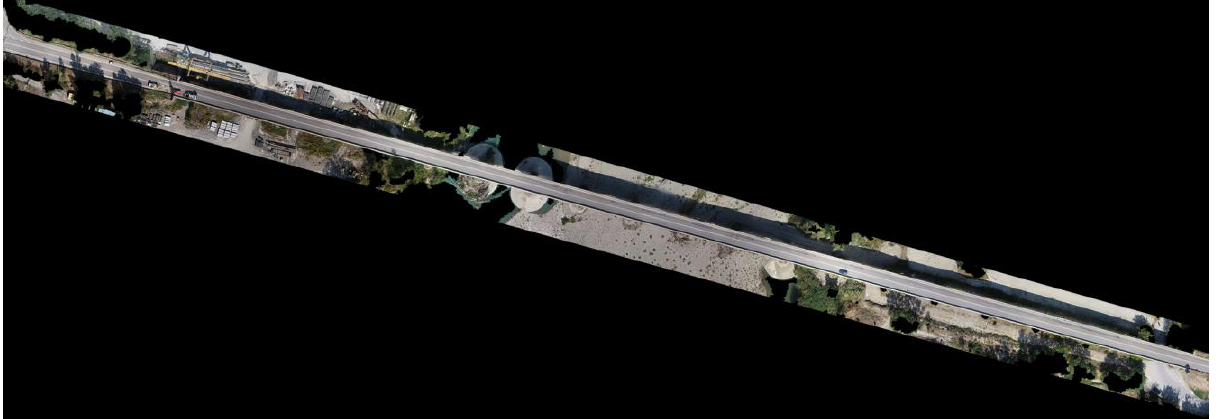
Figure 3. Orthophoto of survey